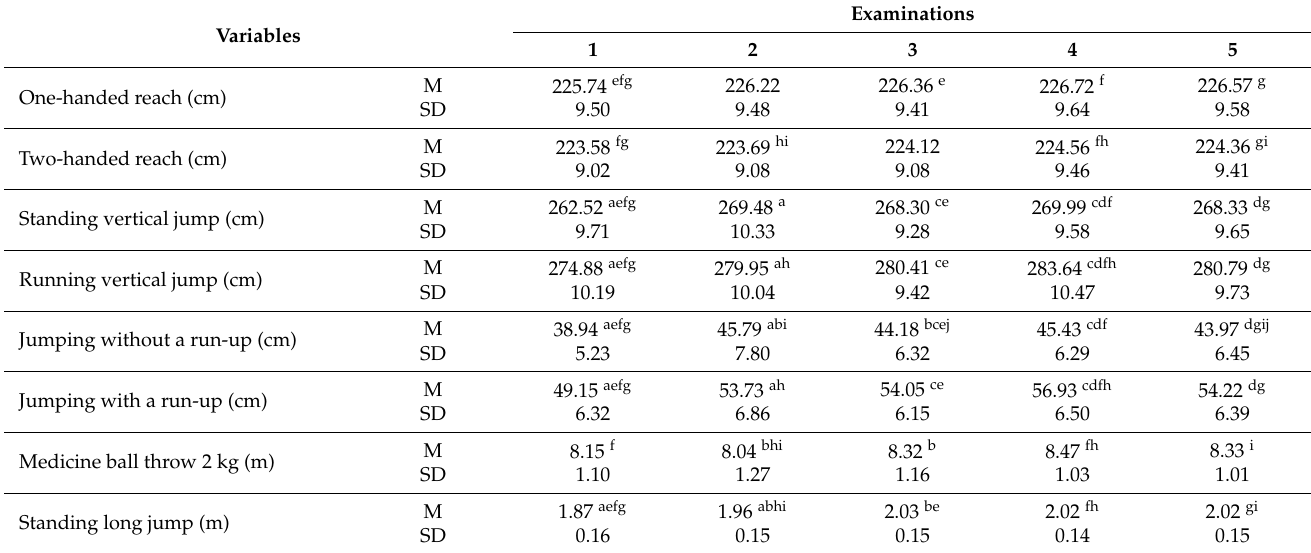
Table 2. Statistical characteristics of the results of motor tests of female volleyball players in subse- quent periods of the